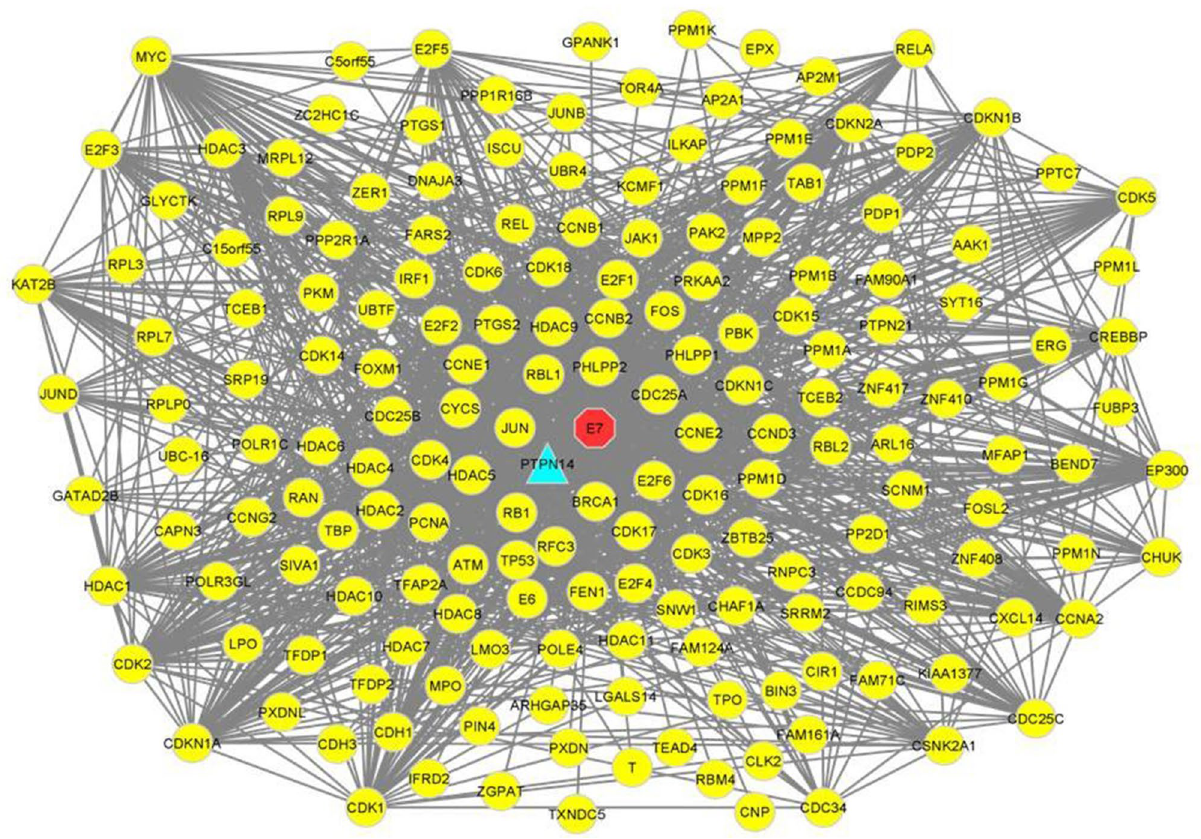
Figure 9. Molecular interactions between HPV E7 oncoprotein and the human proteins involved in cervical